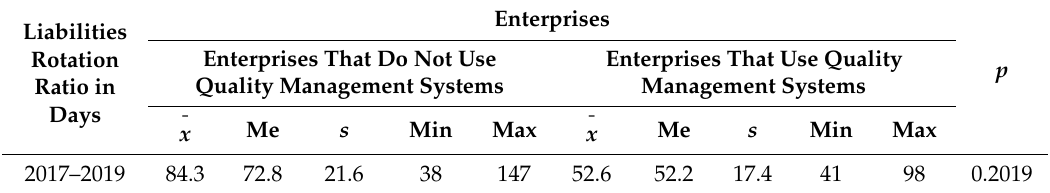
Table 6. Average results for the liabilities rotation ratio in days.